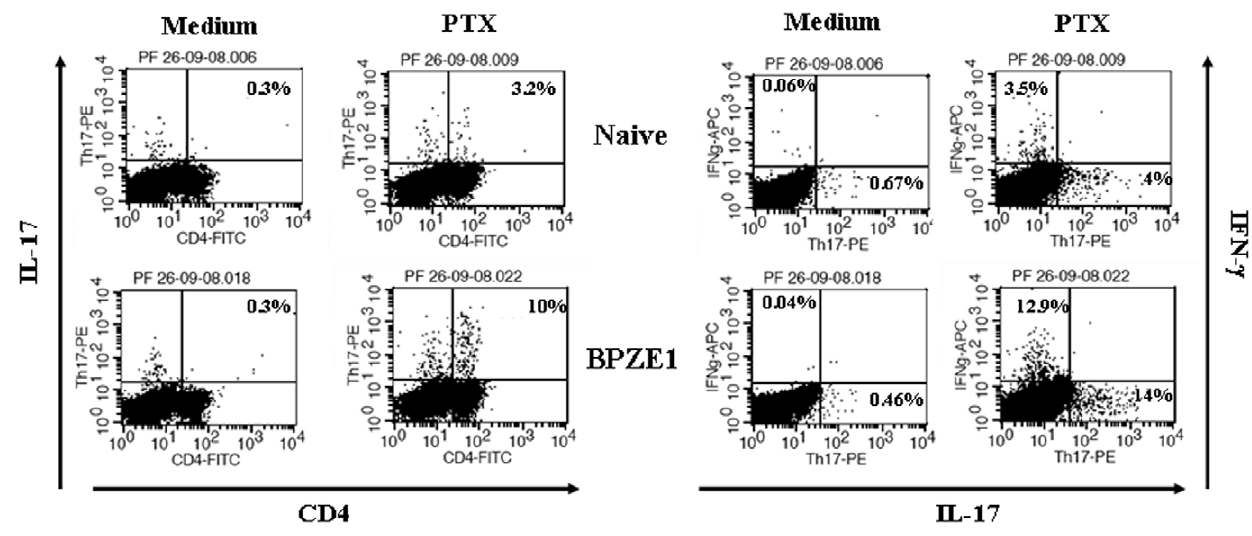
Figure 5. IFN- c and IL-17 are produced by distinct B.pertussis -specific CD4 + T cell subsets from BPZE1-immunized mice. BALB/c mice were left untreated (Naı¨ve) or immunized intranasally with 10 6 CFU of B. pertussis BPZE1 (BPZE1). Eight weeks later, the mice were sacrificed, and spleens of three individual mice per group were pooled and homogenized to obtain single-cell suspensions. 2.5 6 10 6 cells were cultured in triplicate overnight in the presence (PTX) or absence (Medium) of 10 m g/ml PTX. Spleen-derived T cells were then labelled for surface expression of CD4, and intracellular IFN- c and IL-17 expression was assessed by flow cytometry. The results are representative of three independent experiments.